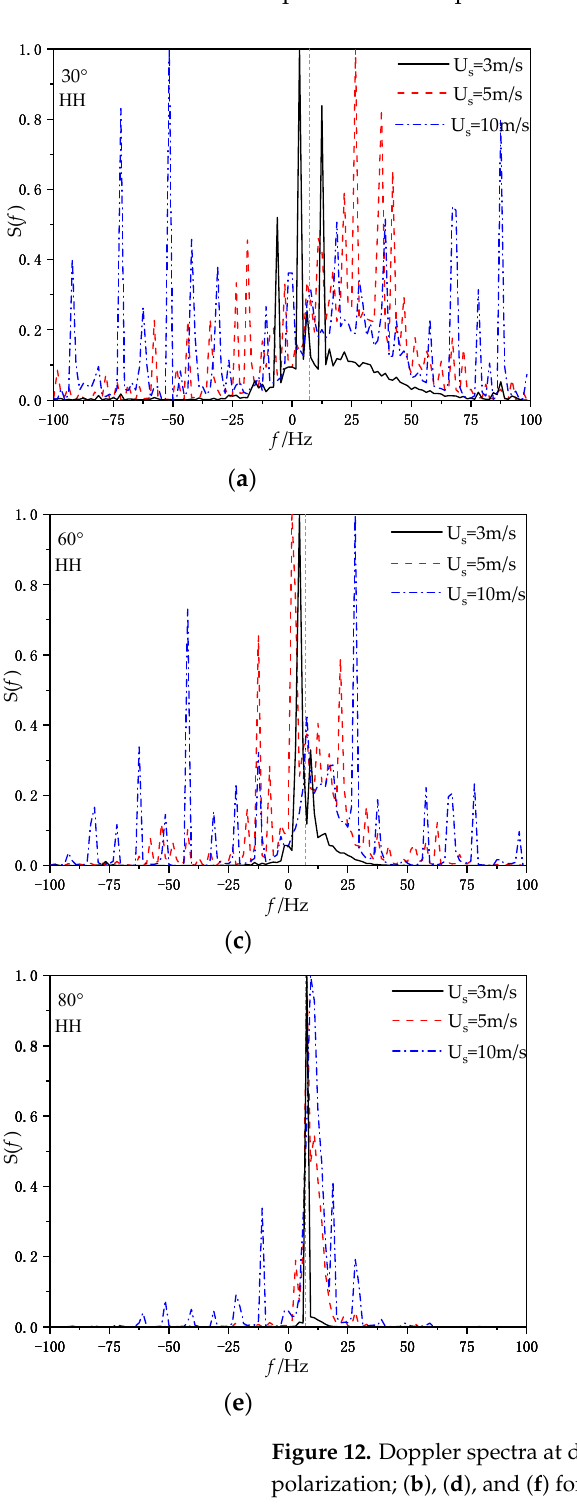
Figure 11. Change of modulus of radar scattering echo with time. The simulation of the backscattering Doppler spectrum when the incident electro- magnetic wave frequency is 5 GHz will be analyzed below. In the resulting Doppler spec- trum, the location of the Bragg frequency is marked by a green vertical line.